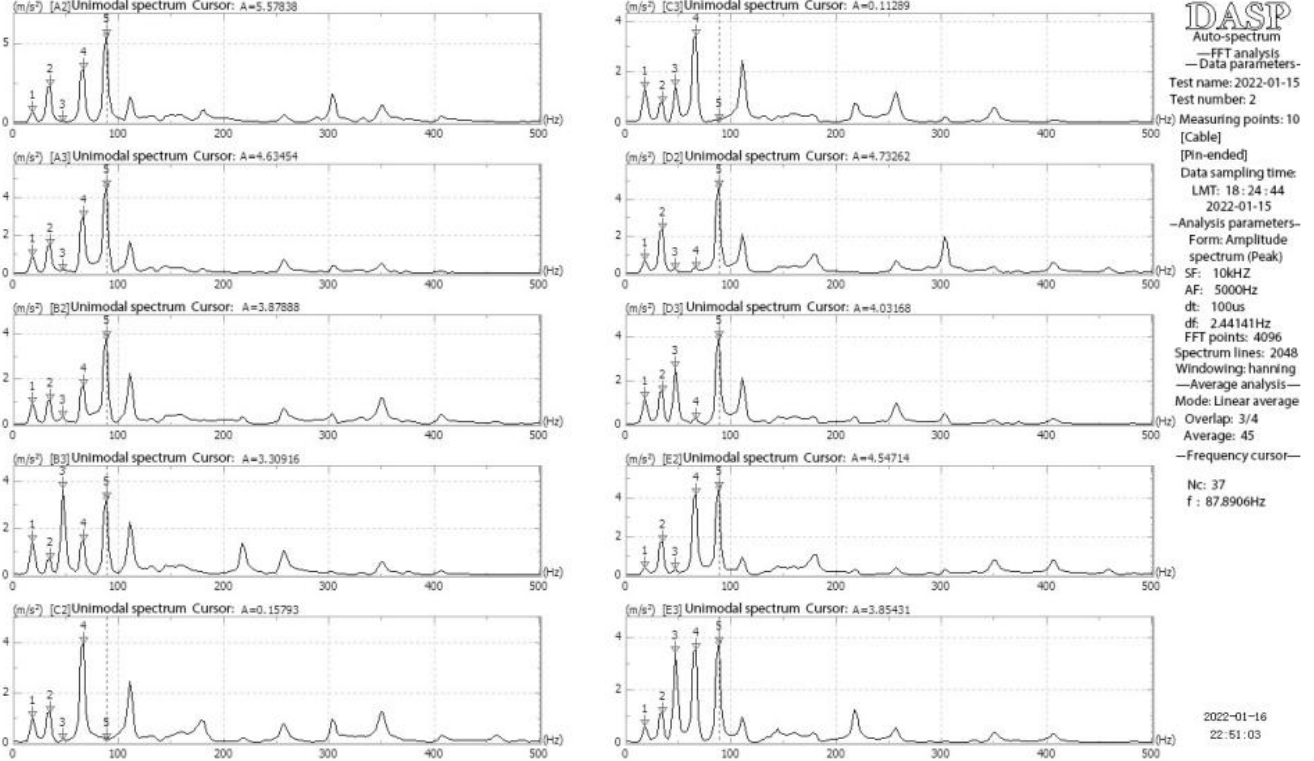
Figure 15. Self-spectral analysis of the acceleration response.